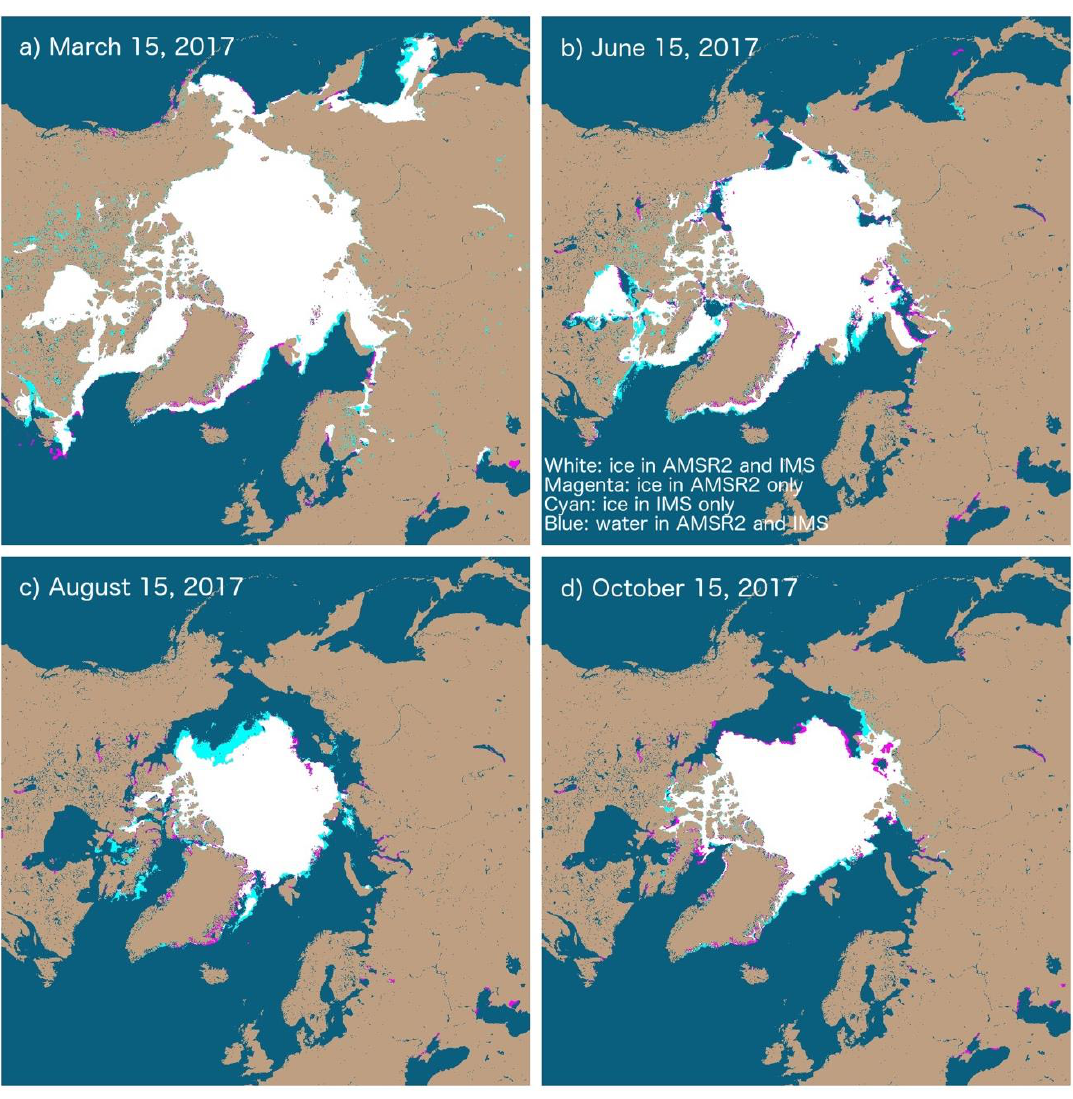
Figure 10. Ice extent from AMSR2 and IMS on ( a ) 15 March 2017, ( b ) 15 June 2017, ( c ) 15 August 2017, and ( d ) 15 October 2017. White: ice in both AMSR2 and IMS; Magenta: ice in AMSR2 and water in IMS; Cyan: water in AMSR2 and ice in IMS.